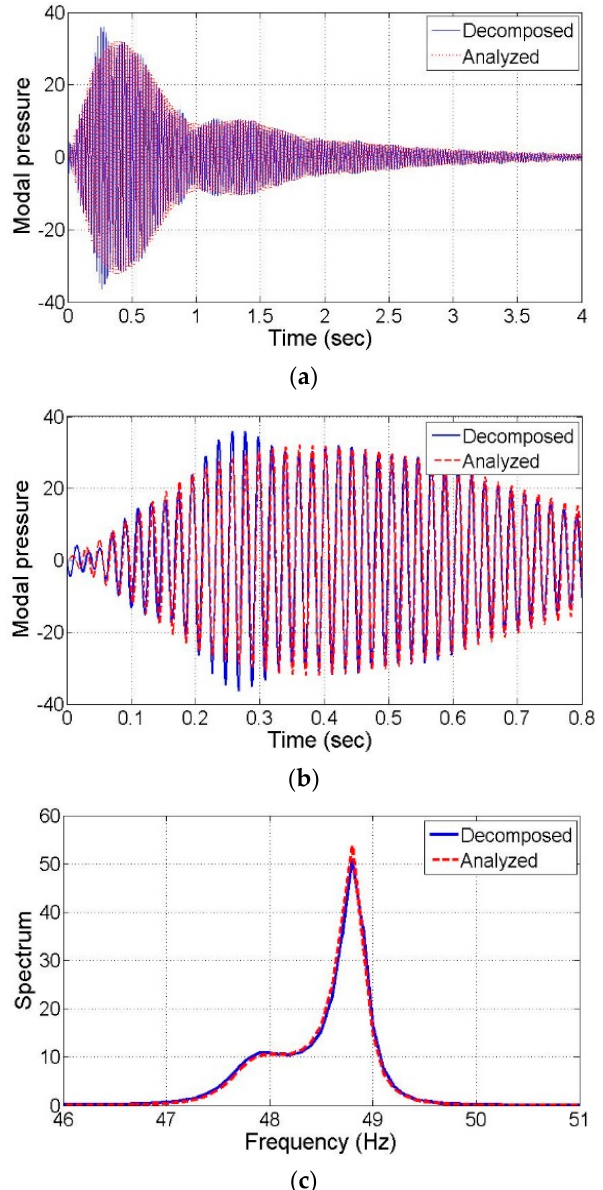
Figure 6. Comparison between acoustic mode from measured data and acoustic mode calculated by measured vibration data using theory. ( a ) Time history of modal pressure; comparison of time history decomposed data from measurement to analyzed data from FEM. ( b ) Modal pressure; a comparison of modal enlarged time history. ( c ) Spectrum; comparison of spectrum decomposed data from measurement to analyzed data from